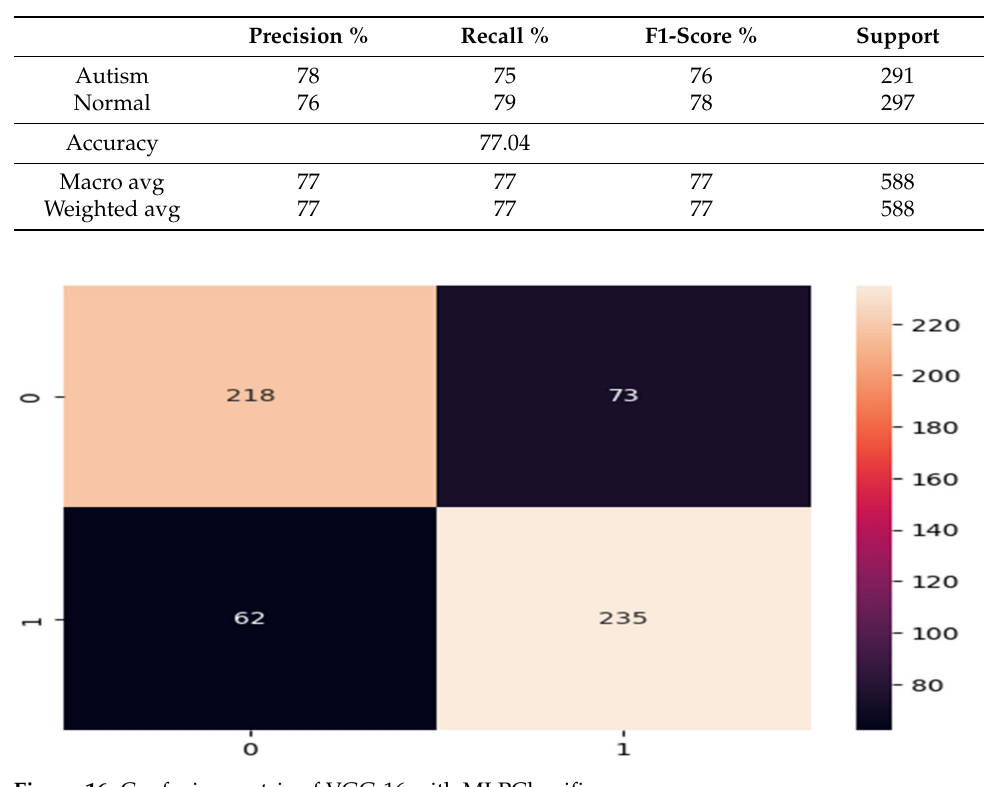
Figure 16. Confusion matrix of VGG-16 with MLPClassifier.